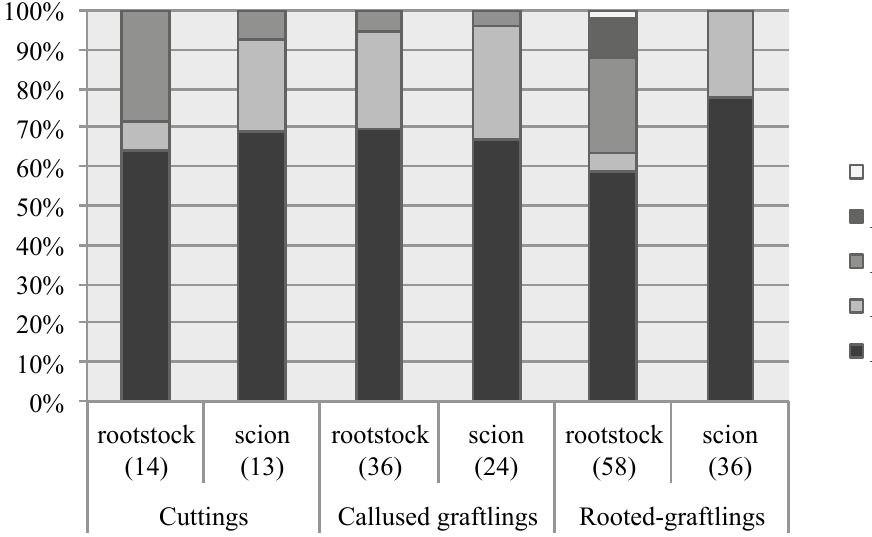
Figure 1. Proportion of Ilyonectria liriodendri , I. macrodidyma complex and “ Cylindrocarpon ” pauciseptatum , alone or in combi- nation, on different grapevine propagation materials, by multiplex nested PCR (sample size in